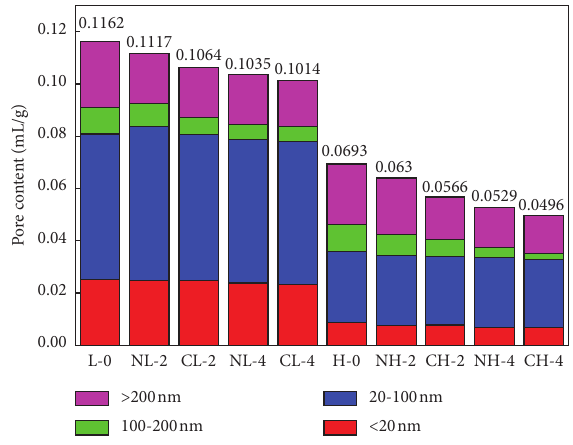
Figure 8: Pore content of